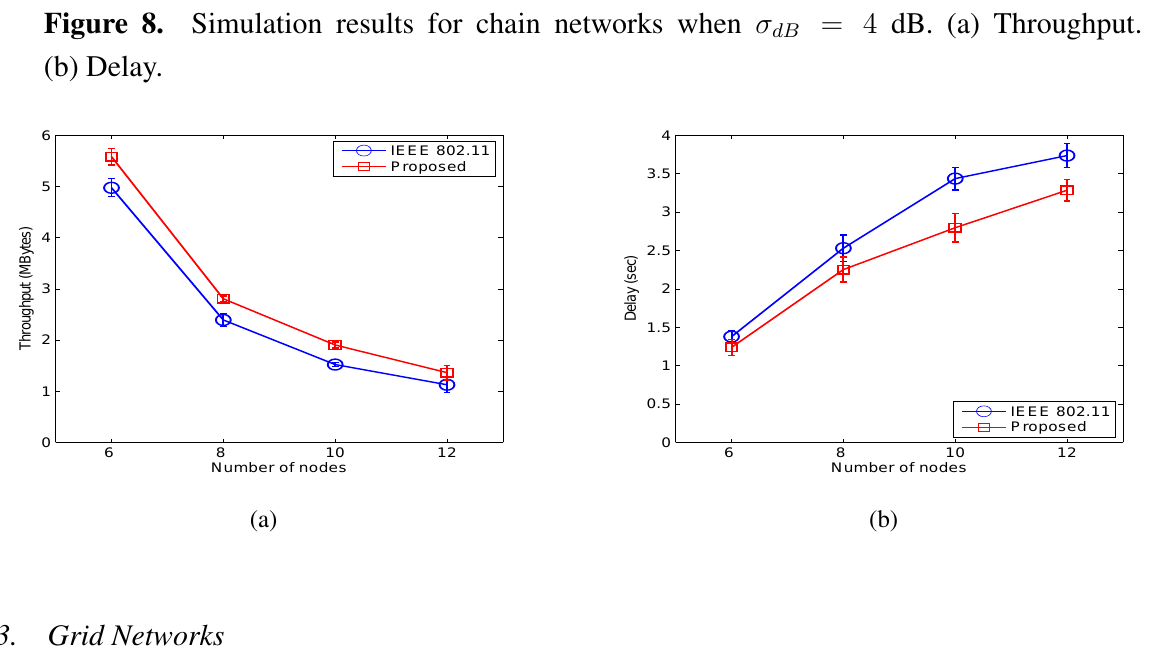
Simulation results for chain networks when σ